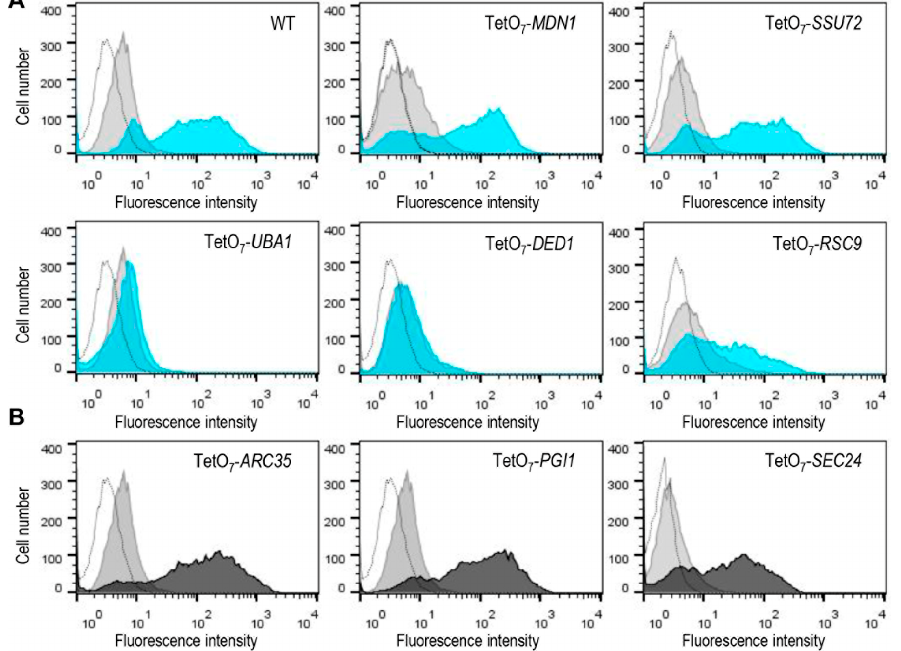
Figure 2. Identification of mutants from the yTHC collection that exhibit altered Mlp1-GFP levels by flow cytometry analysis. ( A ) Representative experiments of mutants in which Mlp1-GFP fluorescence levels were found to be affected (lower panels), or not affected (upper panels), compared with those of the wild-type strain. For each strain, histograms show the distribution of GFP fluorescence under non-stress conditions (grey-filled) and after treatment with Calcofluor white (10 μ g/mL for 3 h) (blue-filled) in the presence of doxycycline (10 μ g/mL). ( B ) Examples of mutants displaying increased GFP signal under non-stress conditions (absence of CW) in the presence of doxycycline are shown. For each conditional allele, histograms show basal GFP fluorescence corresponding to wild-type (grey-filled) and mutant (black-filled) strains handled in parallel. Control cells that do not express GFP are shown in each histogram overlay (unfilled peaks).